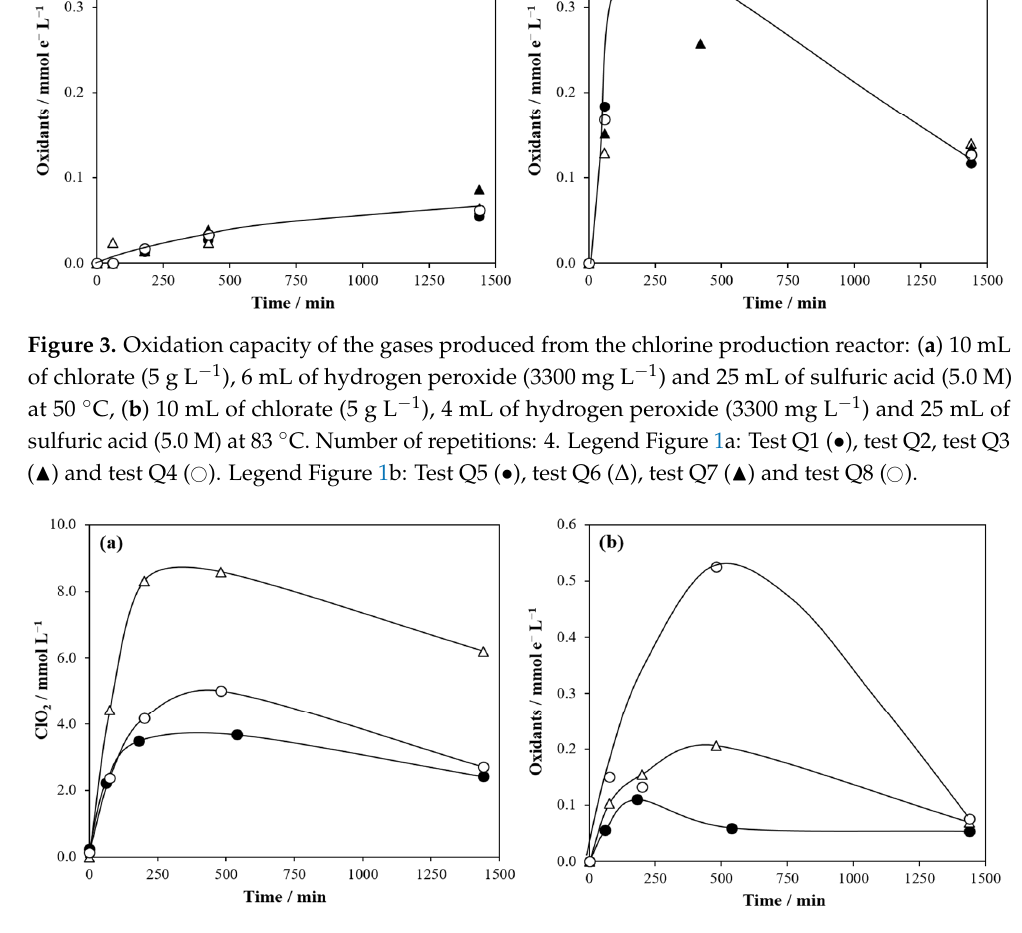
Figure 3. Oxidation capacity of the gases produced from the chlorine production reactor: ( a ) 10 mL of chlorate (5 g L − 1 ), 6 mL of hydrogen peroxide (3300 mg L − 1 ) and 25 mL of sulfuric acid (5.0 M) at 50 °C, ( b ) 10 mL of chlorate (5 g L − 1 ), 4 mL of hydrogen peroxide (3300 mg L − 1 ) and 25 mL of sulfuric acid (5.0 M) at 83 °C. Number of repetitions: 4. Legend Figure 1a: Test Q1 ( ● ), test Q2, test Q3 ( ▲ ) and test Q4 ( ○ ). Legend Figure 1b: Test Q5 ( ● ), test Q6 ( ∆ ), test Q7 ( ▲ ) and test Q8 ( ○ ).